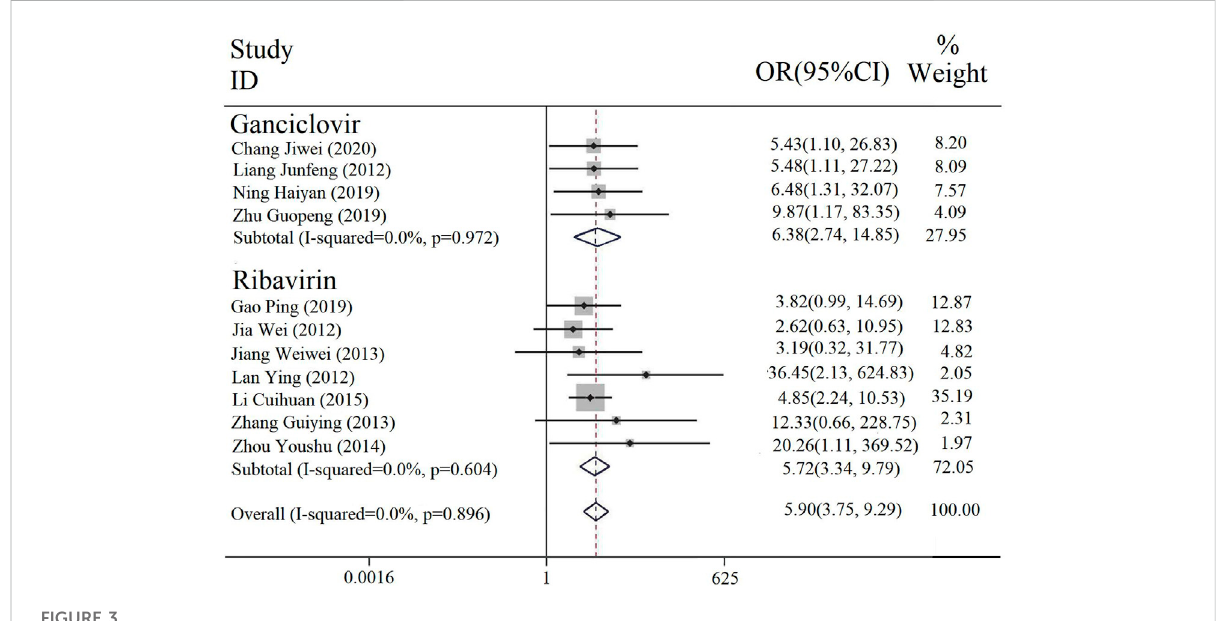
FIGURE 3 Forest plot of effective rate comparison among groups.